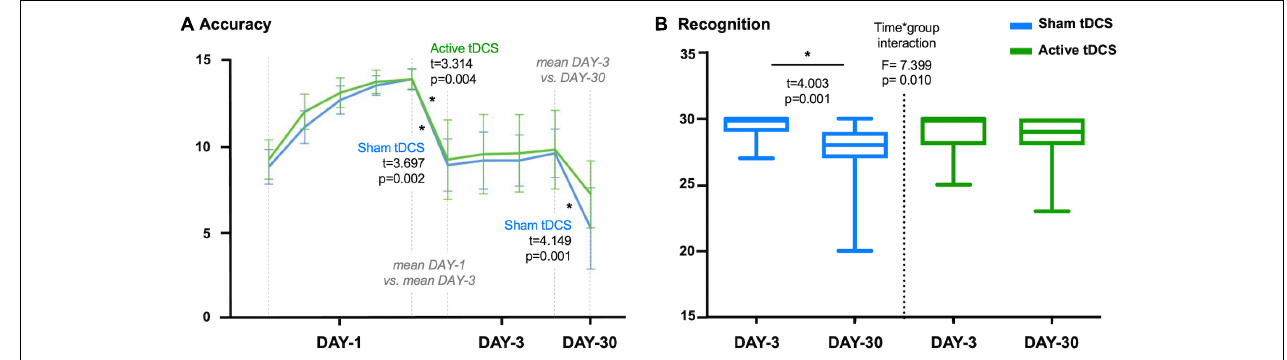
FIGURE 2 | (A) Accuracy scores for sham-tDCS and active-tDCS groups at each experimental session: five attempts on first session (DAY-1), four attempts on third session (DAY-3) and one attempt on follow-up session (DAY-30). Note that differences between measures are calculated considering the mean accuracy at DAY-1 and DAY-3. (B) Plot showing the time*group interaction in recognition. The sham-tDCS group showed a significant decline after 1-month follow-up, while there was not a significant difference between DAY-3 and DAY-30 for the active-tDCS group. tDCS, transcranial direct current stimulations. * p <